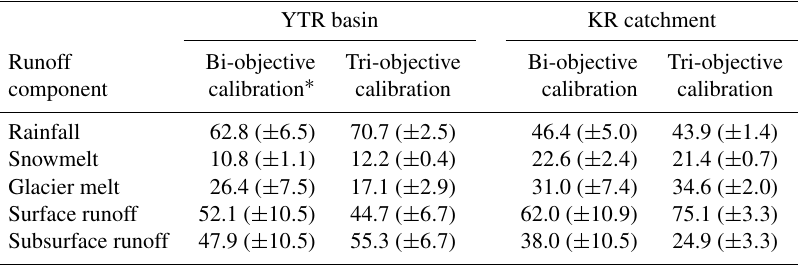
Table 4. Contributions (%) of runoff components in the YTR basin and KR catchment estimated by different calibration variants in the benchmark scenario.